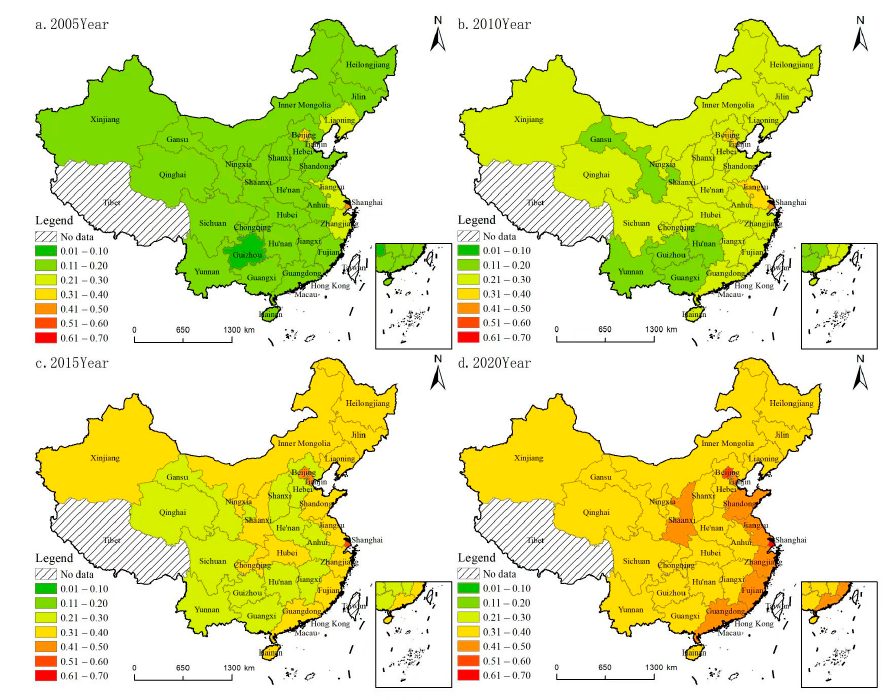
Figure 2. Development level of new-type urbanization. From 2005 to 2020, the overall level of new-type urbanization gradually increased, with the new-type urbanization development level of the 30 provinces reaching above 0.3 in 2020. The regional distribution of the new-type urbanization level is also very evident,